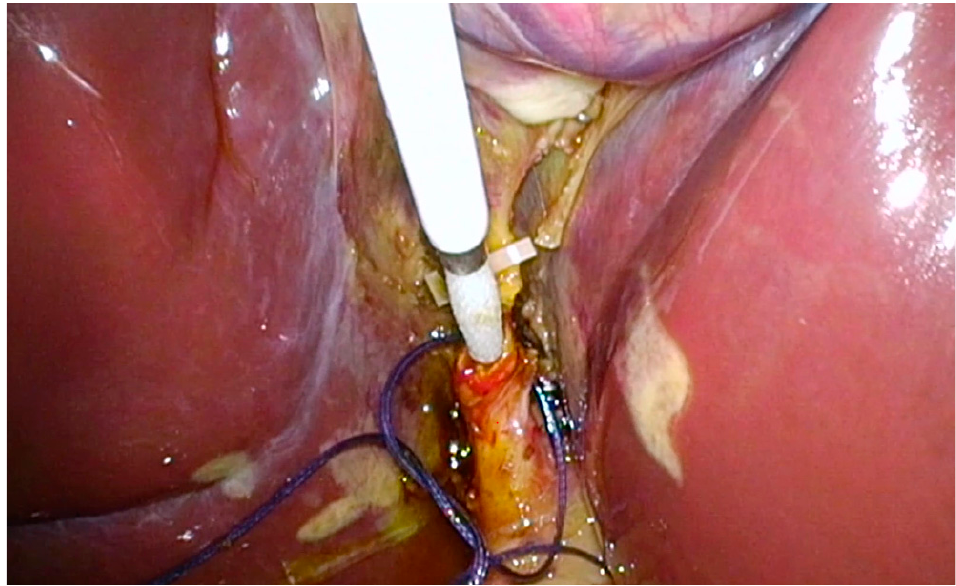
Figure 2. Insertion of the AeroStat cholangiography catheter and prepared ligature (see also Video S1). The patient was placed in a reverse Trendelenburg position, and the cholangiography was performed using fluoroscopy for dynamic visualization of the biliary tree. This showed the intrahepatic bile ducts as well as the common bile duct without dilatation and a free passage of the contrast medium into the duodenum. During irrigation of the common bile duct with normal saline serum, a small stone in the common bile duct could easily be flushed out (Figure 3). After extraction of the cholangiography kit, the cystic duct was closed by placing two clips on the permanent side and then divided. There was no intraoperative bile leak.